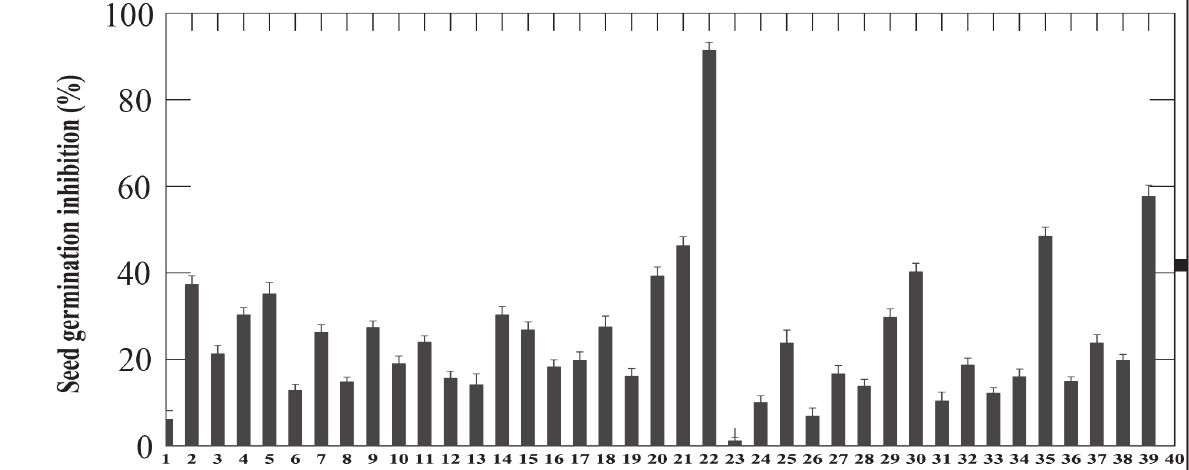
Fusarium spp. Figure 2a. Toxicity of the Fusarium isolates on the seed germination of Orobanche crenata . The numbering of the 39 Fusarium isolates is as in Tables 1 and 2. Error bars are standard errors.